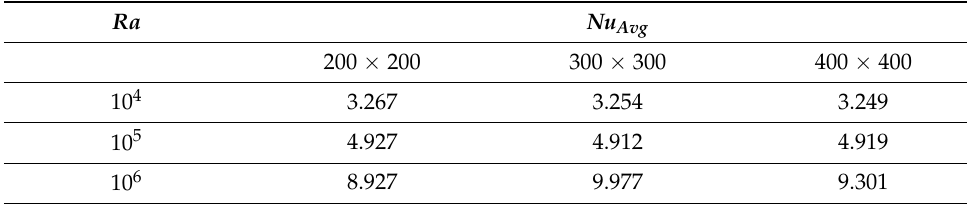
Table 2. Comparison of average Nusselt number Nu Avg against ( Ra ) .